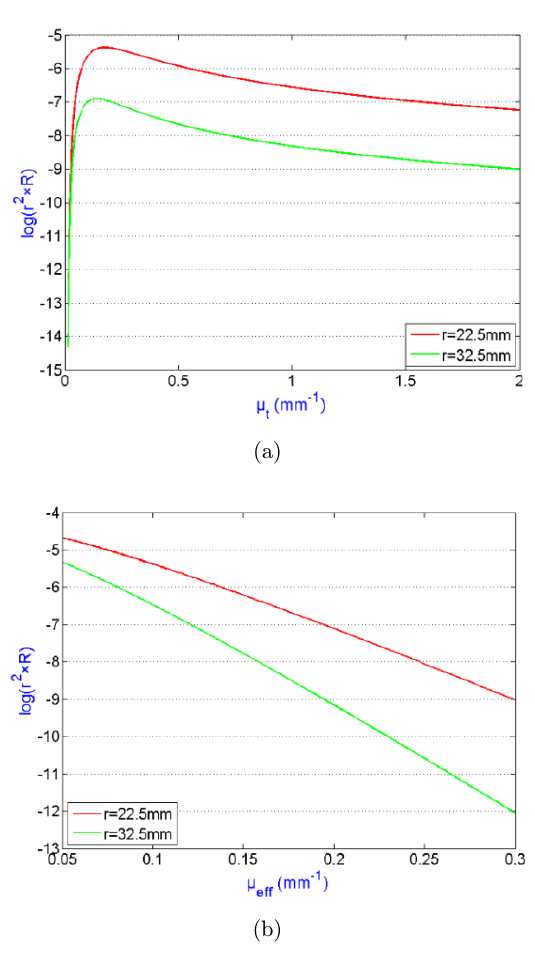
Fig. 3. (a) Plot of log ( r 2 (cid:1) R ) versus (cid:1) 0 t while (cid:1) eff ¼ 1 : 7 mm (cid:2) 1 , and (b) plot of log ( r 2 (cid:1) R ) versus (cid:1) eff while (cid:1) 0 ¼ 1 mm (cid:2) 1 in the source-detection separation of 22.5 mm and t 32.5